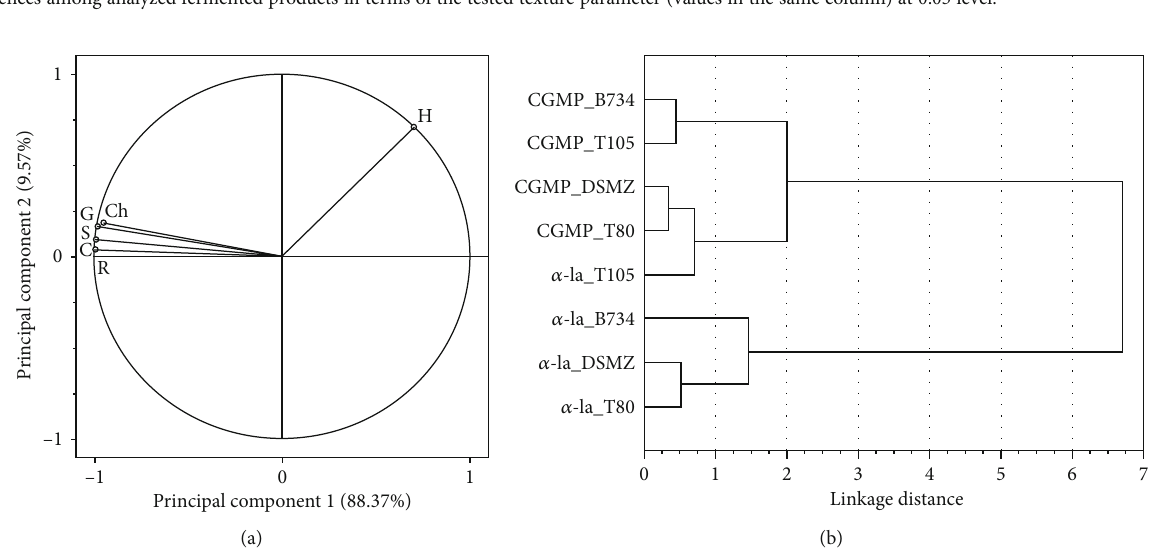
Figure 1: Projection of variables on the principal component plane ((a) H: hardness; Ch: chewiness; G: gumminess; S: springiness; C: cohesiveness; R: resilience) and dendrogram showing the results of hierarchical cluster analysis comparing the texture pro fi les of fermented milk beverages